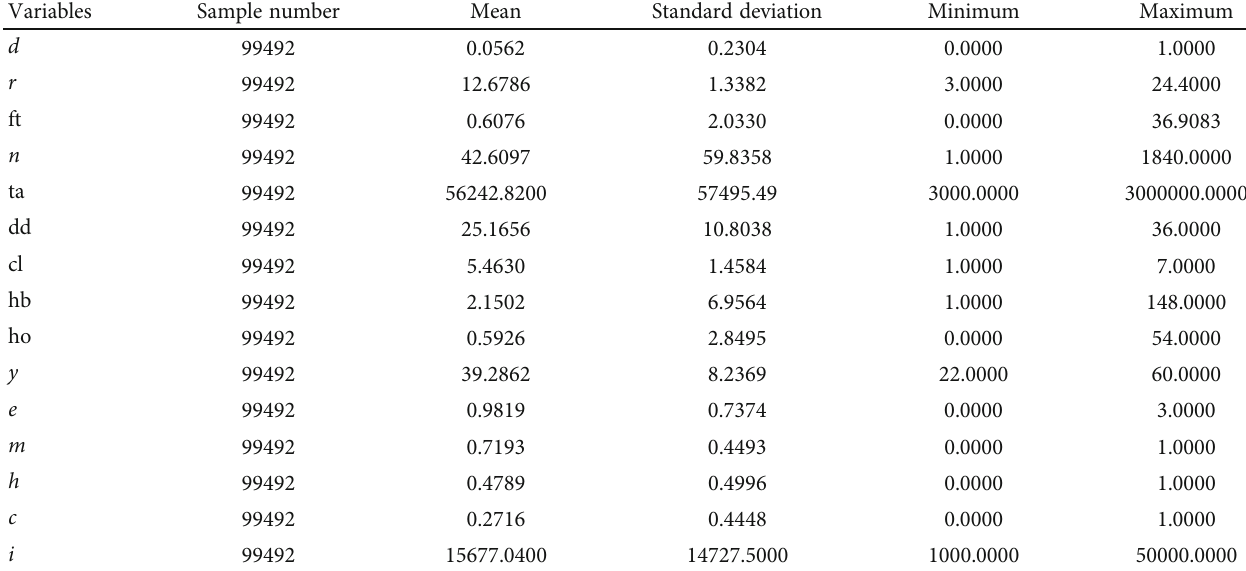
Table 1: Samples of statistical